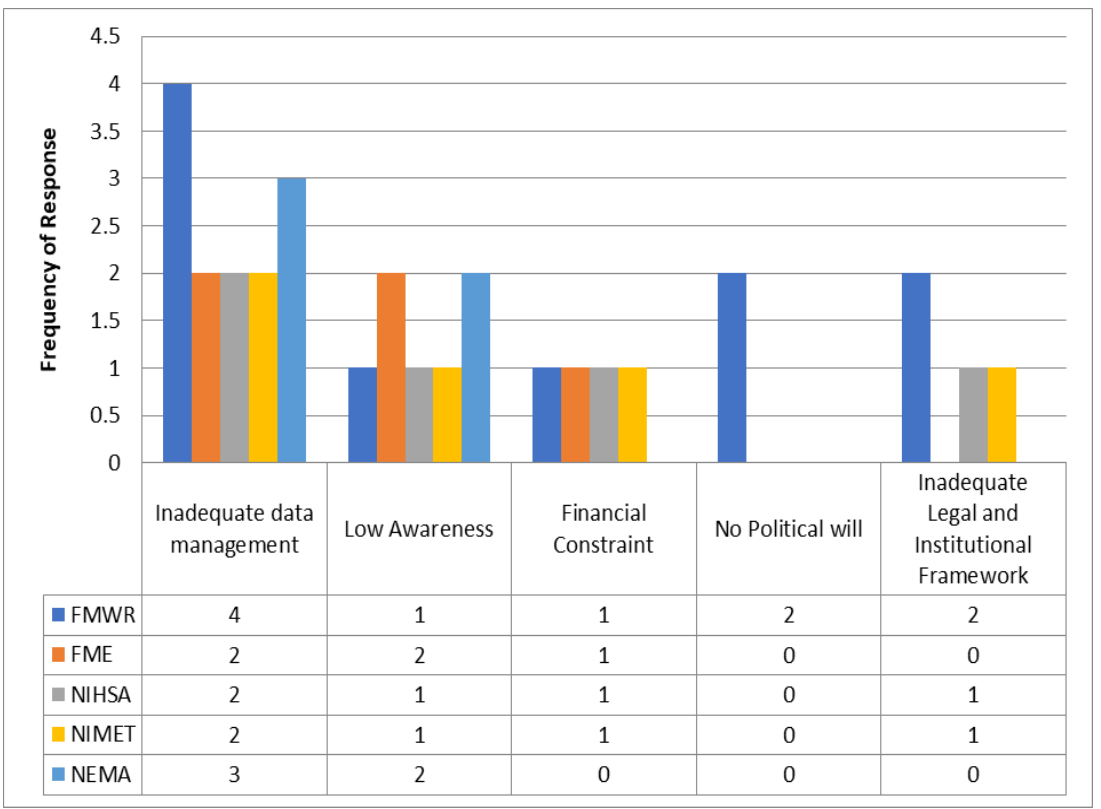
Figure 3. Respondents’ opinions on institutional challenges. Note: FMWR = Federal Ministry of Water Resources; FME = Federal Ministry of Environment; NIHSA = Nigeria Hydrological Services Agency; NIMET = Nigeria Meteorological Agency; NEMA = National Emergency Management Agency.